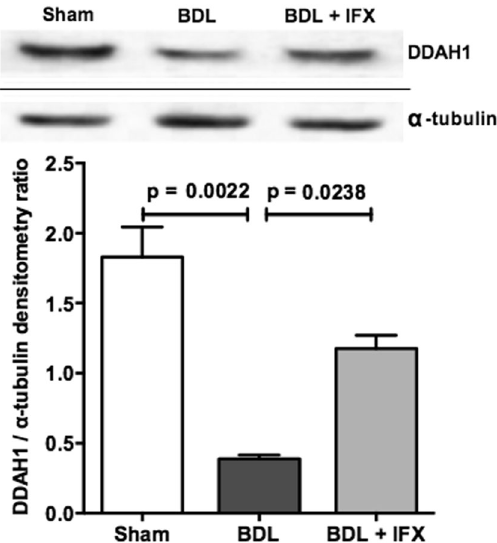
Figure 4. DDAH1 expression in rat liver. Western blot analysis shows that DDAH1 protein expression is reduced in livers of BDL rats compared to sham rats, and is increased in BDL rats treated with IFX. Following detection of DDAH1, western blots were stripped and reprobed for detection of α -tubulin. (Sham n = 6; BDL n = 6; BDL + IFX n = 3).